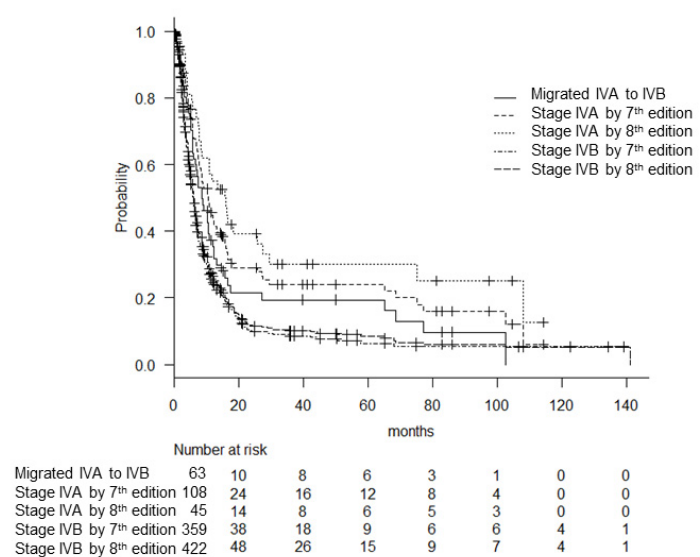
Figure 3. The patients who migrated from stage IVA of the 7th edition to stage IVB of the 8th edition showed significantly worse survival compared to the revised stage IVA patients ( p = 0.02), as well as better survival than that of the former stage IVB patients ( p = 0.03).